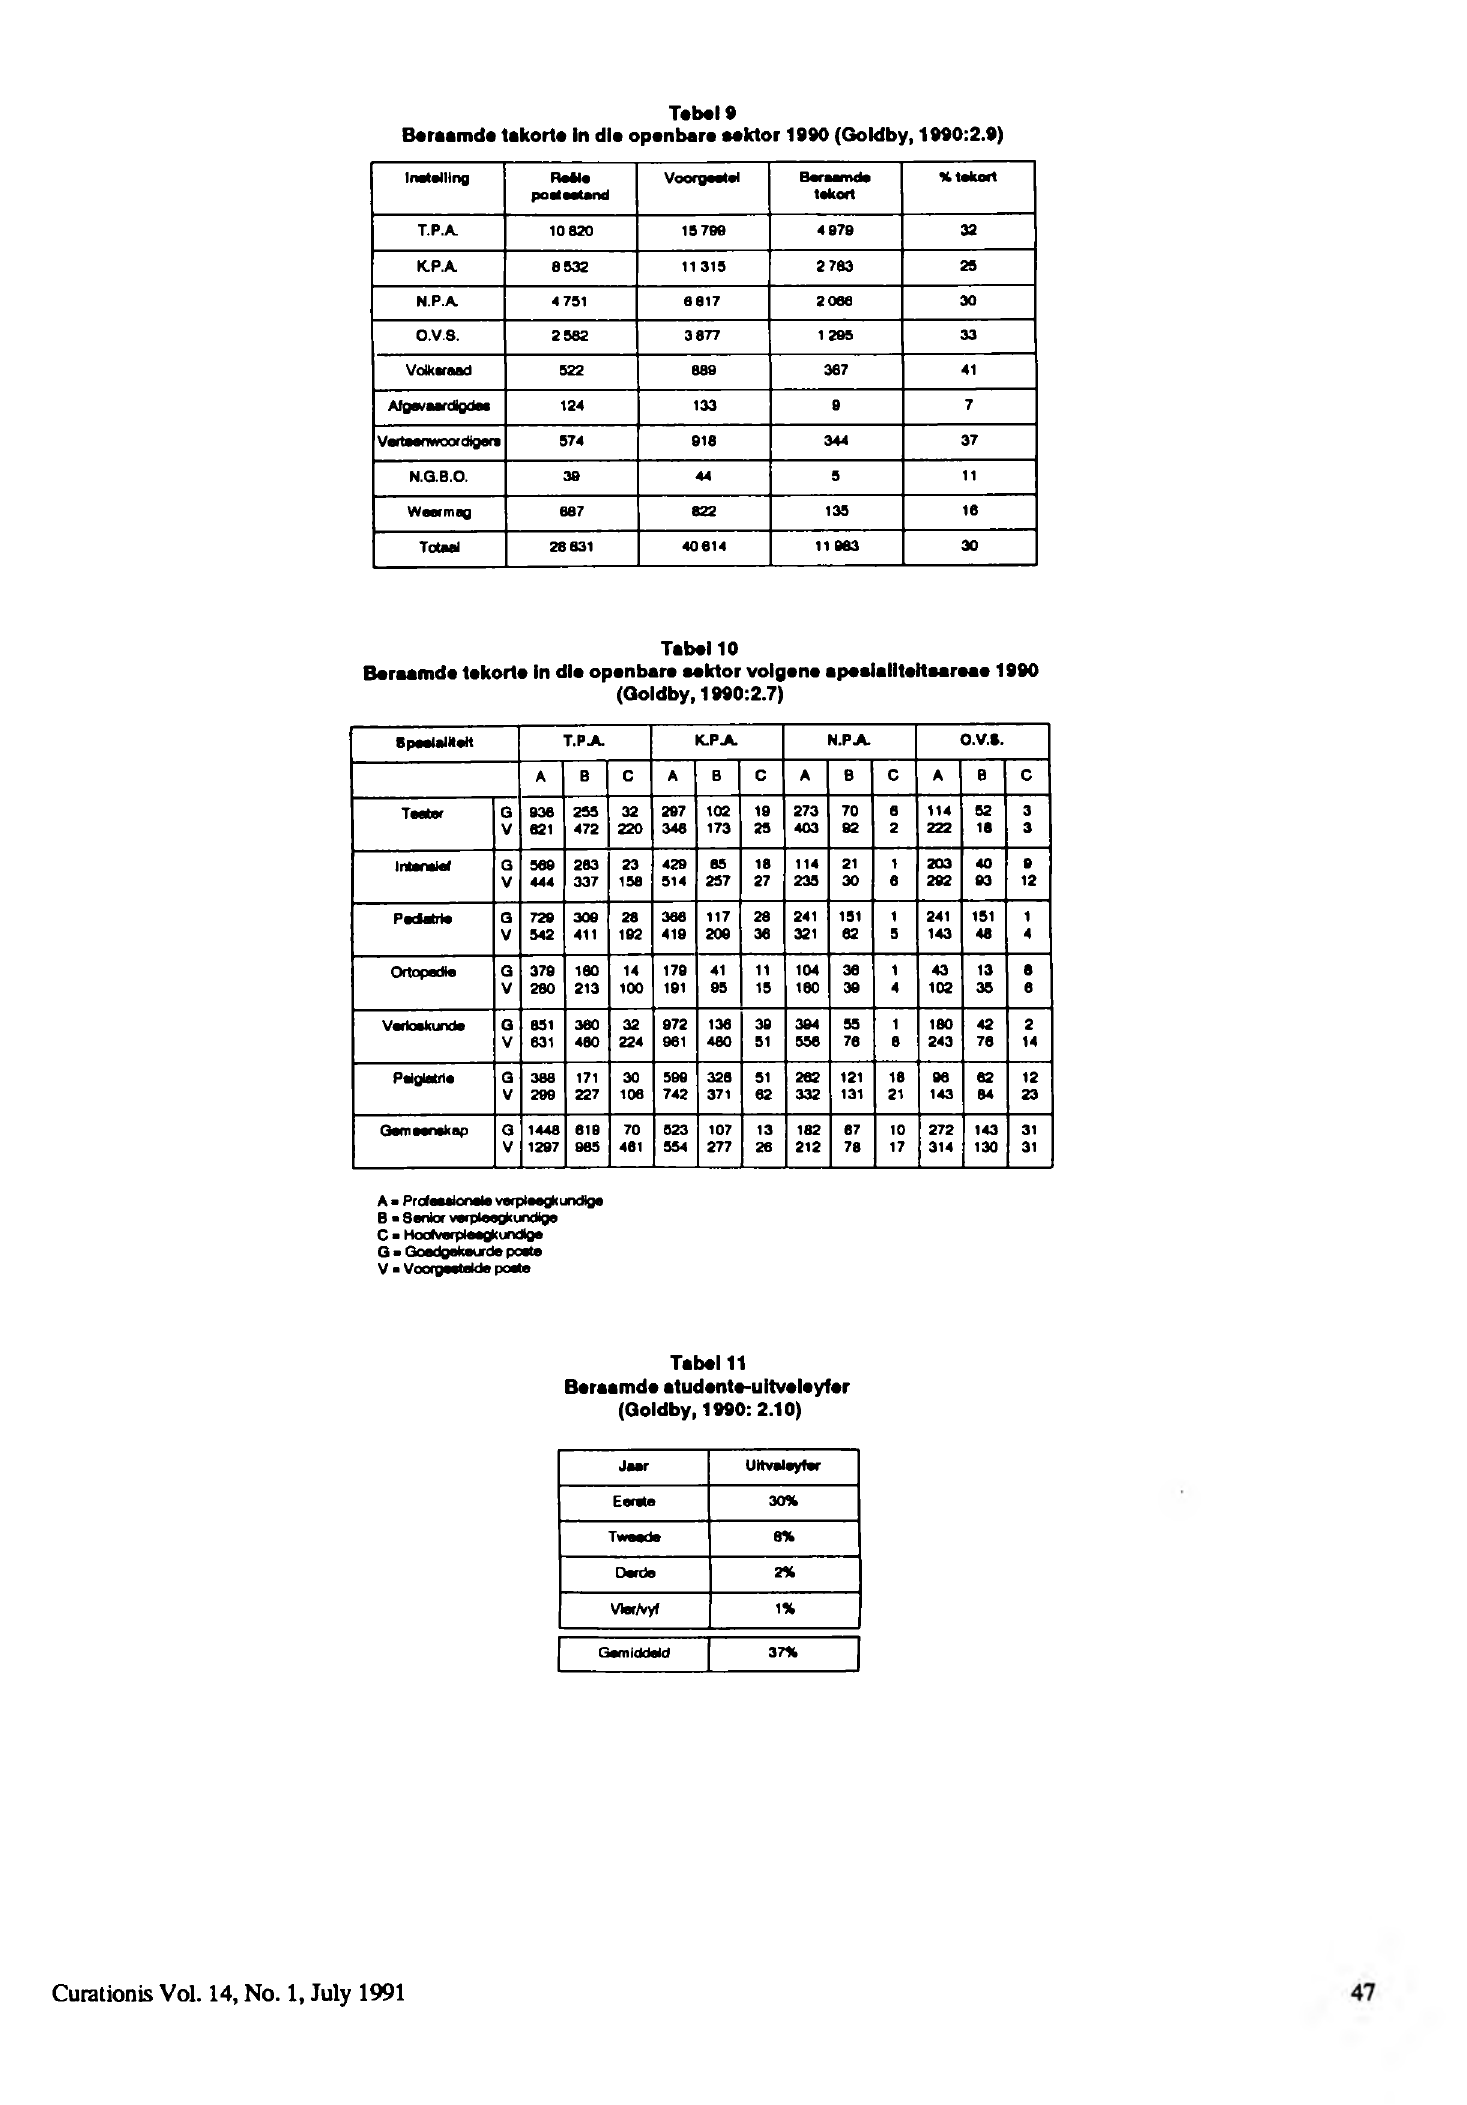
Tabal 11 Baraamda atudanta-ultvalayfar (Qoldby, 1990: